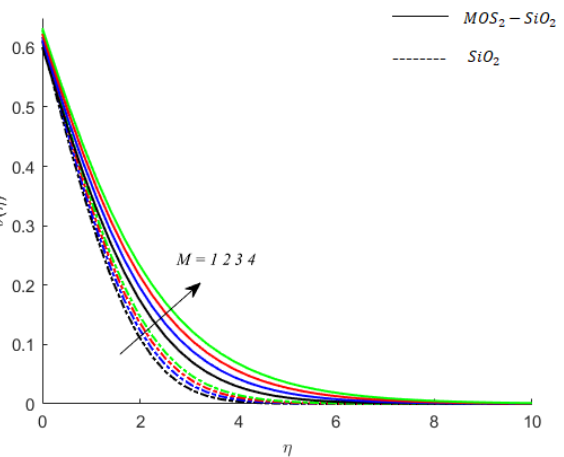
Figure 6. Influence of 𝑀 on temperature when 𝑃𝑟 = 0.9, 𝐸𝑐 = 0.2, 𝑆𝑐 = 0.8, 𝐾 = 0.1, 𝐸𝑖 = 0.1, 𝐵𝑖 = 0.05, 𝛽 ∗ = 0.1, 𝛾 = 0.1, 𝛾 = 0.1 .